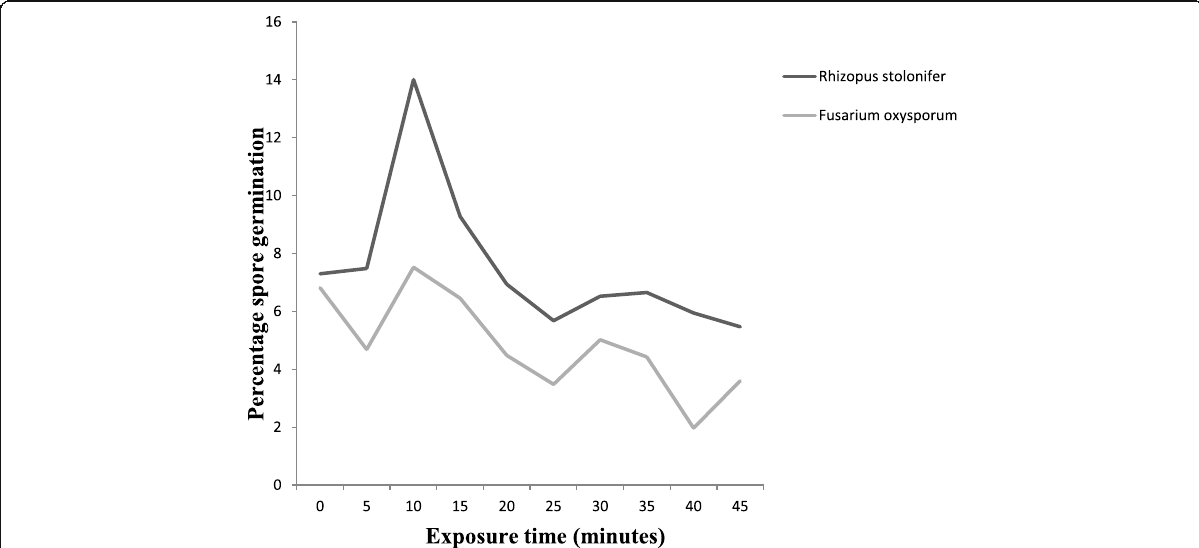
Fig. 1 Percentage germination of Rhizopus stolonifer and Fusarium oxysporum spores after exposure to gasoline emission and incubation at 28 °C